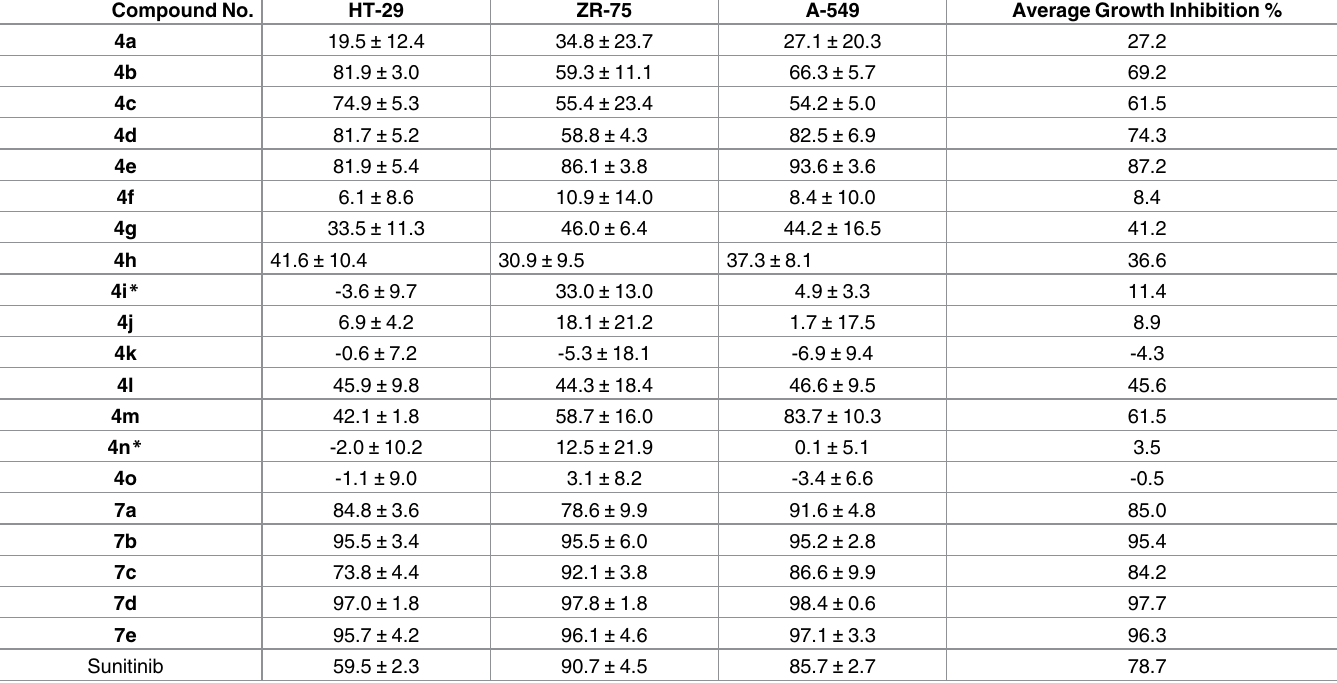
Table 1. Anti-proliferative (cell growth inhibitory activity at 30 μ M concentration) activity of the target compounds 4a-o, 7a-e and sunitinib against HT-29, ZR-75 and A-549 cell lines. Compound No.